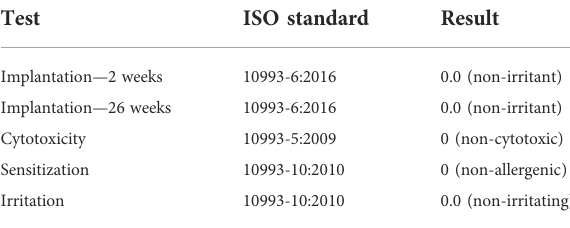
TABLE 1 Biocompatibility testing results. The following table lists the tests that were performed on the magnetic bead implants under GLP, along with the ISO standards that were followed and the corresponding test